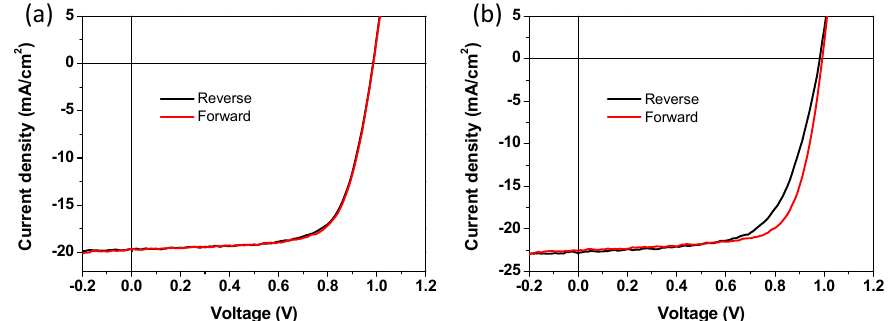
Figure 8. Hysteresis characteristics of perovskite solar cells based on pristine and DMSO solvent washing treated PEDOT:PSS layers.